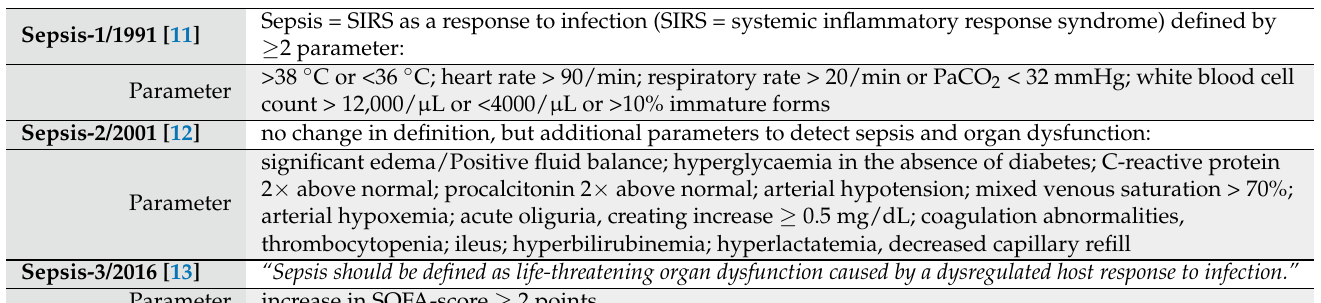
Table 1. Development of sepsis definitions and parameters to detect and define